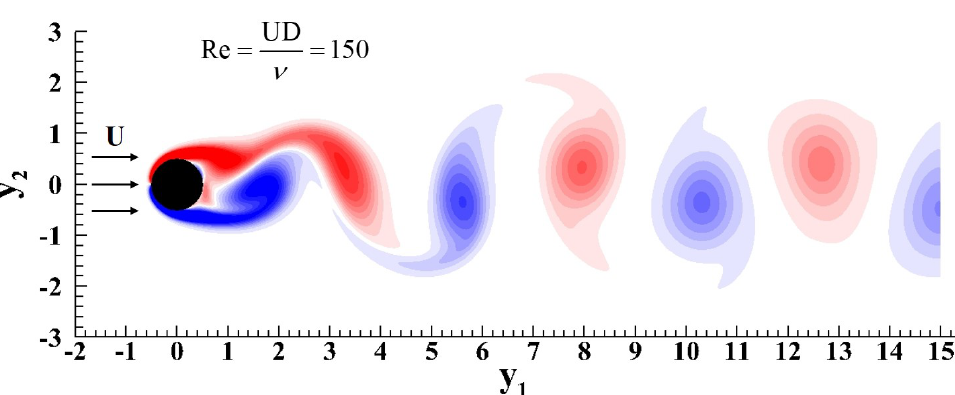
Figure 6. Schematic of the flows over a circular cylinder at a Reynolds number of